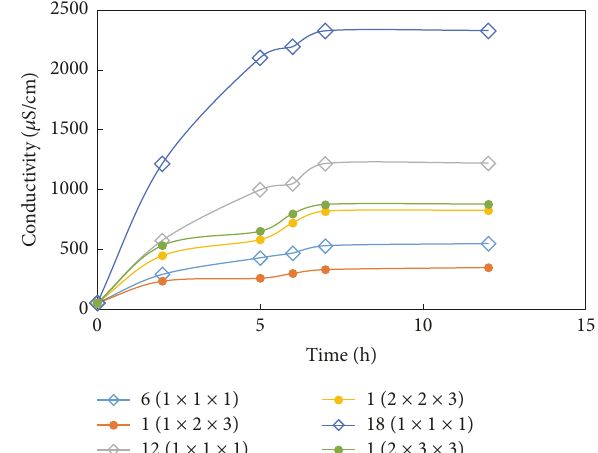
Figure 6: Conductivity changes for different samples for Case 2.